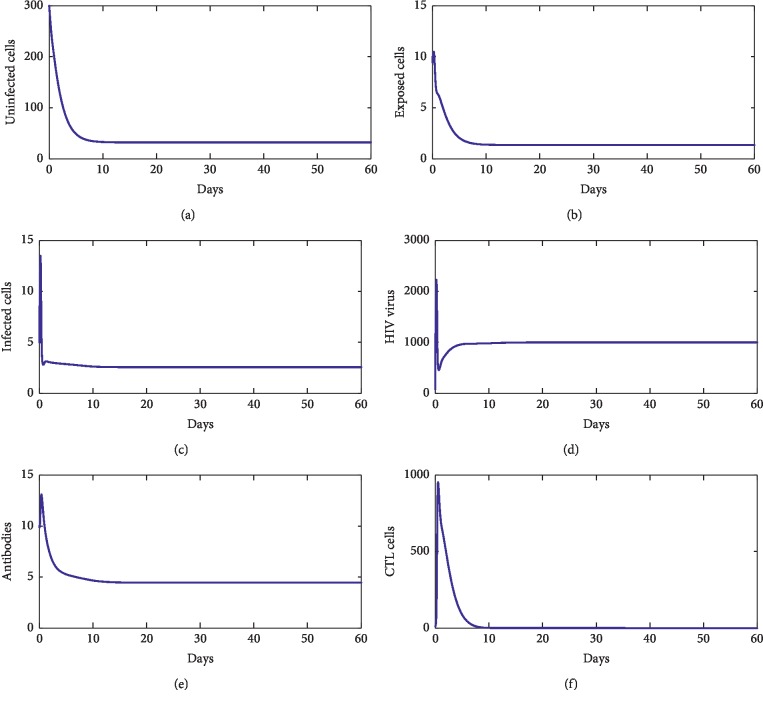
The behavior of the disease for λ=2, d1=0.0139, k1=0.05, d2=0.0495, k2=1.1, d3=0.5776, a=500, d4=0.6, q=0.05, g=10−4, h=0.1, p=0.0024, c=0.15, and b=0.5.